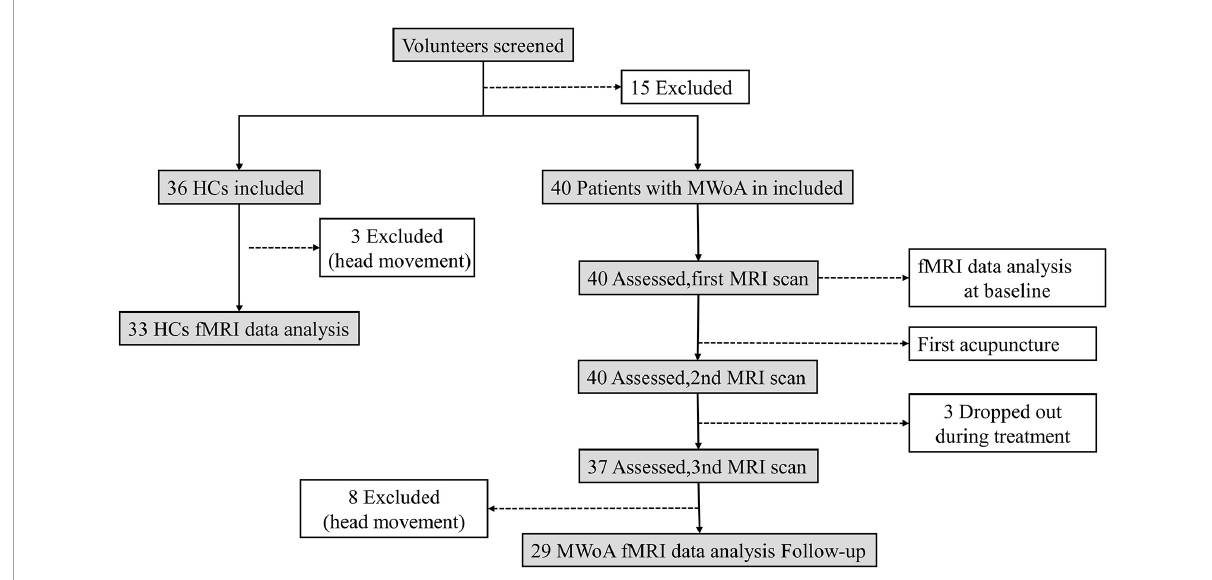
FIGURE1 Flowchart displaying the screening, enrollment, and treatment. All abbreviations are defined in the Abbreviations section.